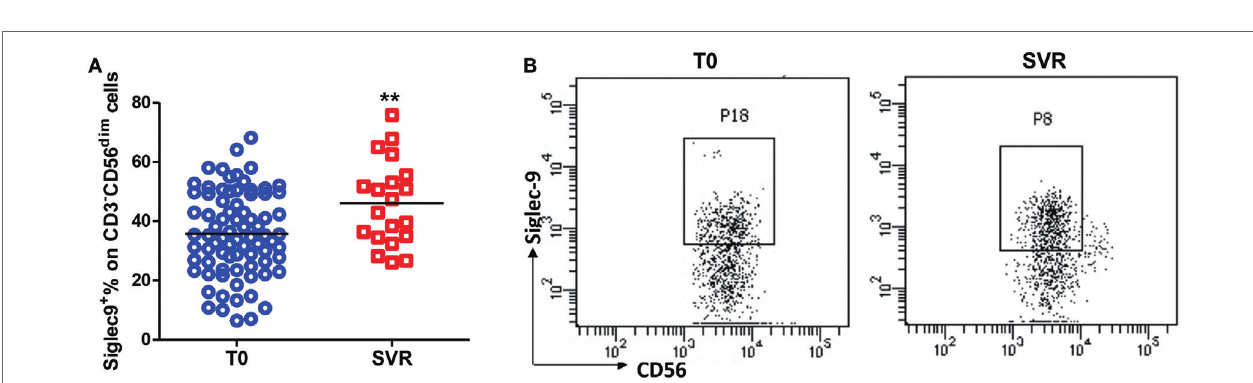
FigUre 3 | Restored Siglec-9 expression on NK cells in chronic hepatitis B (CHB) patients achieving sustained virological response (SVR). (a) The percentage of Siglec-9 expression on CD3 − CD56 dim NK cells in CHB patients without treatment (T0) and in patients achieving SVR. (B) Representative dot plots were shown.